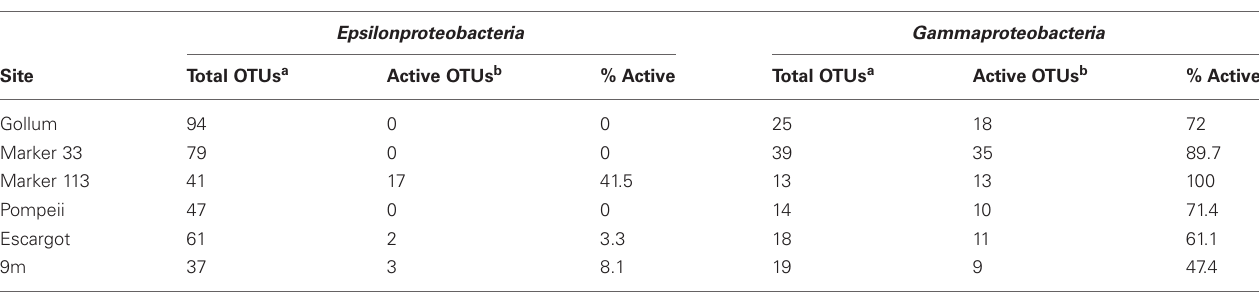
Table 4 | Predicted percent activity based on 16S rRNA gene